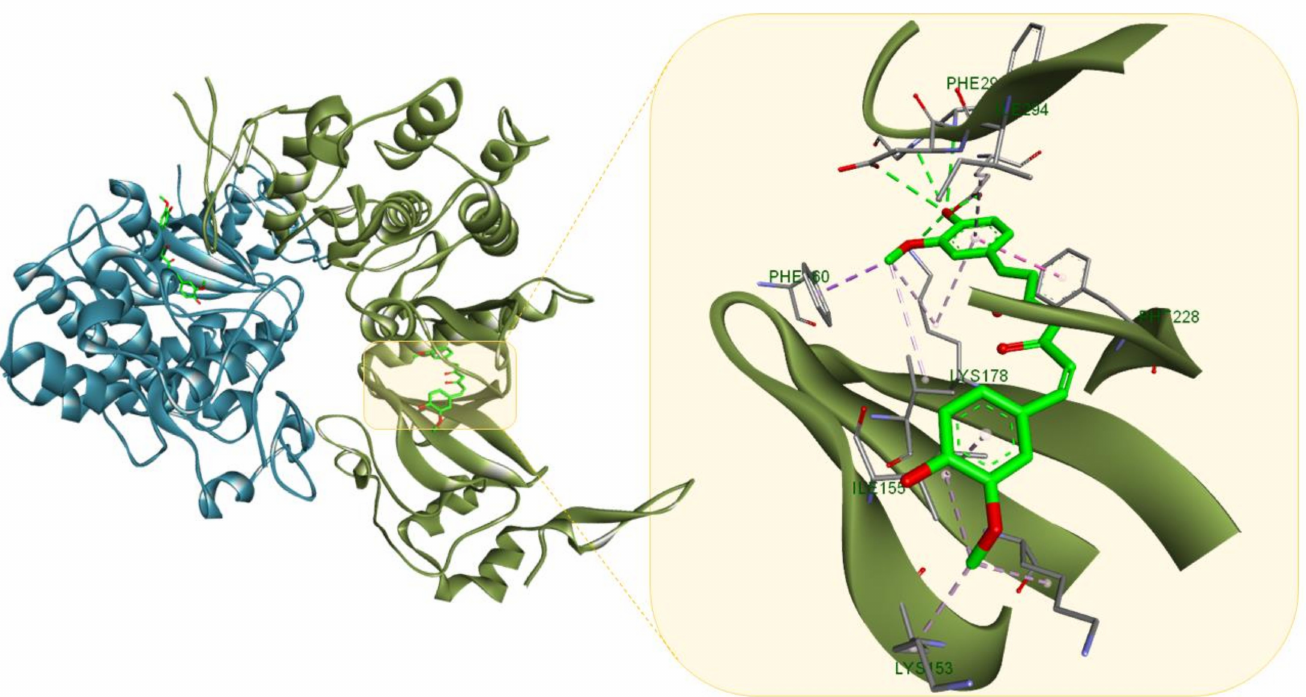
Figure 7. Curcumin (light green) in in complex with DYRK2 (PDB ID: 5ZTN); the compound interacts with the surrounding aminoacid residues through multiple HBs (green dotted lines) and several hydrophobic interactions (purple dotted lines). Protein-ligand representation was achieved using Biovia Discovery Studio 4.1 (Dassault